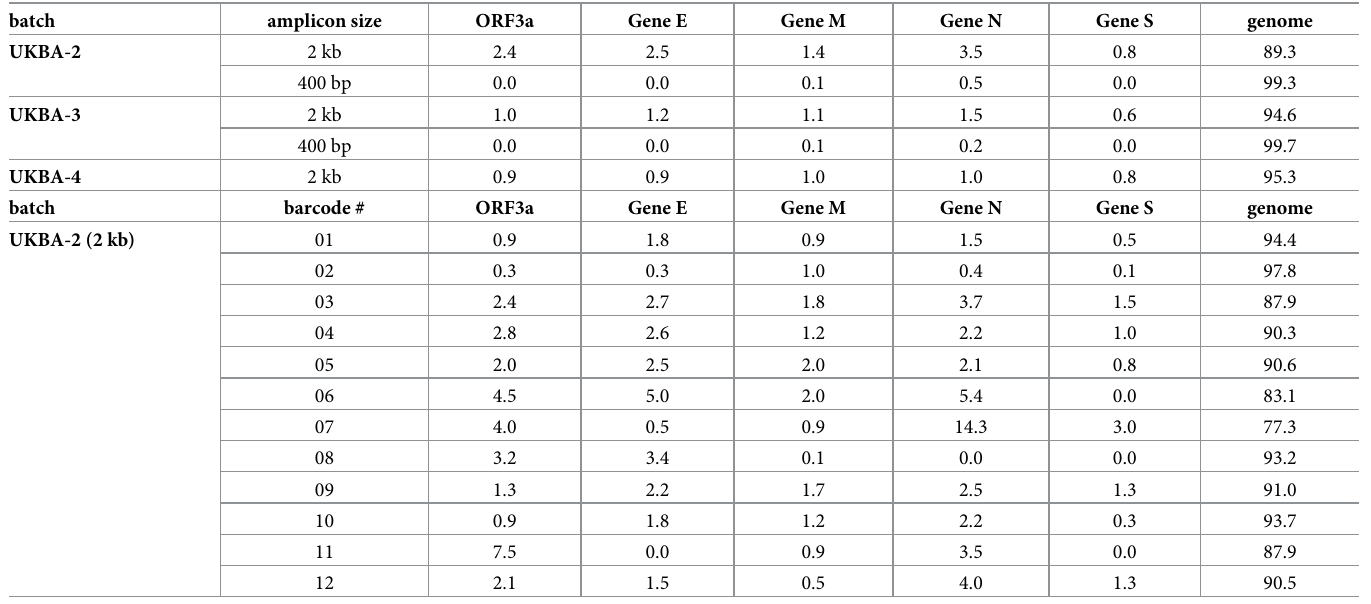
Only genes with the highest numbers of sub-genomic RNA reads are shown. Top: statistics for different MinION runs with the standard flow cells. Bottom: statistics for different barcodes of batch UKBA-2, 2-kb